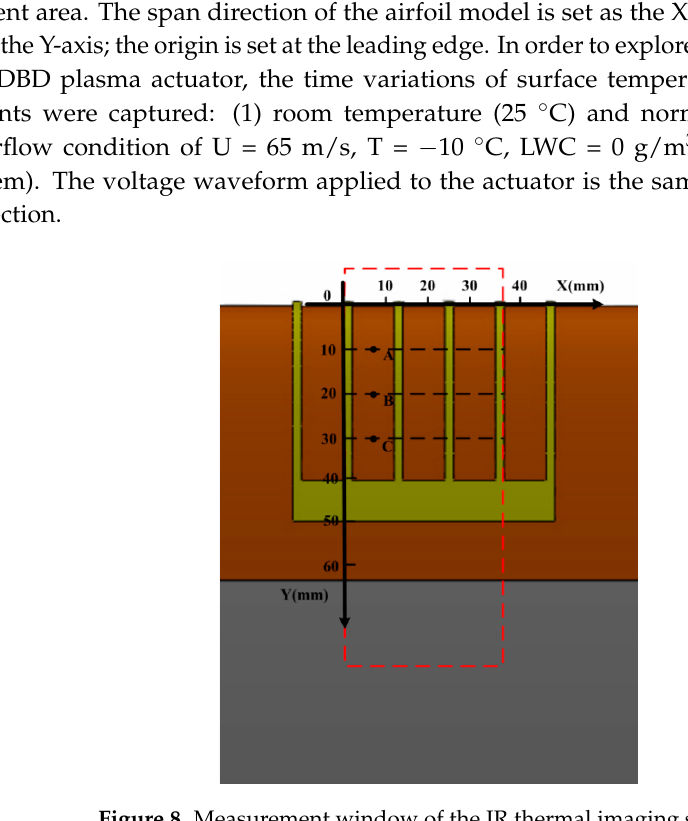
Figure 8. Measurement window of the IR thermal imaging system.